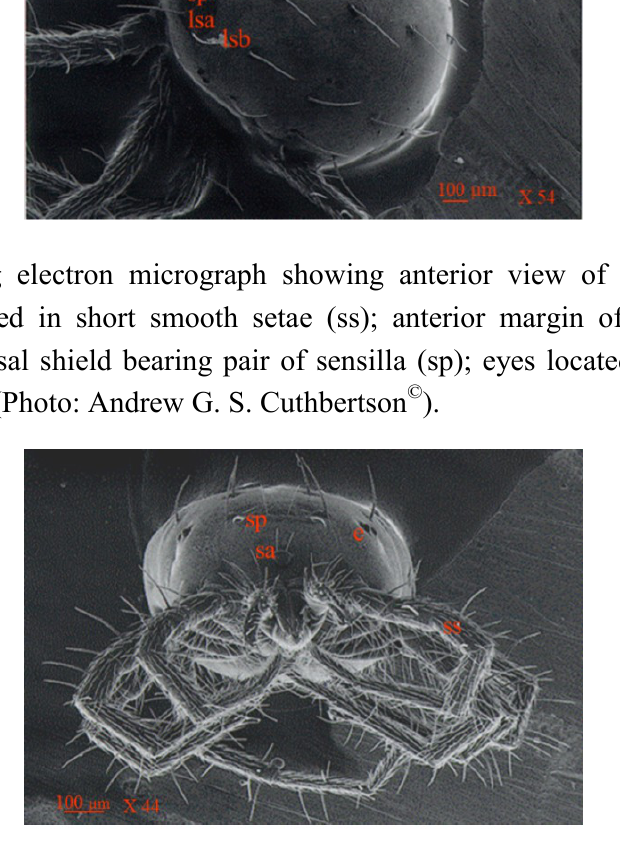
Figure 7. Scanning electron micrograph of Anystis baccarum claw. Each tarsus terminates in two claws (c) and an empodium (e); two brush like setae present at base of claws (bs) (Photo: Andrew G. S. Cuthbertson ©